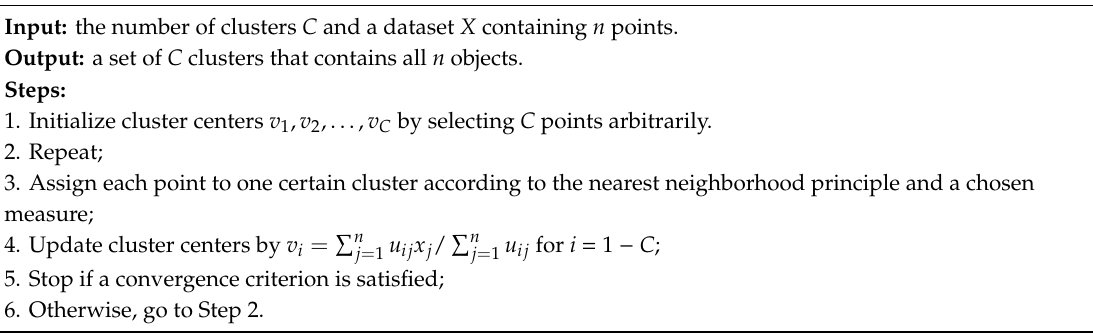
Algorithm 1. C-means Clustering Algorithm